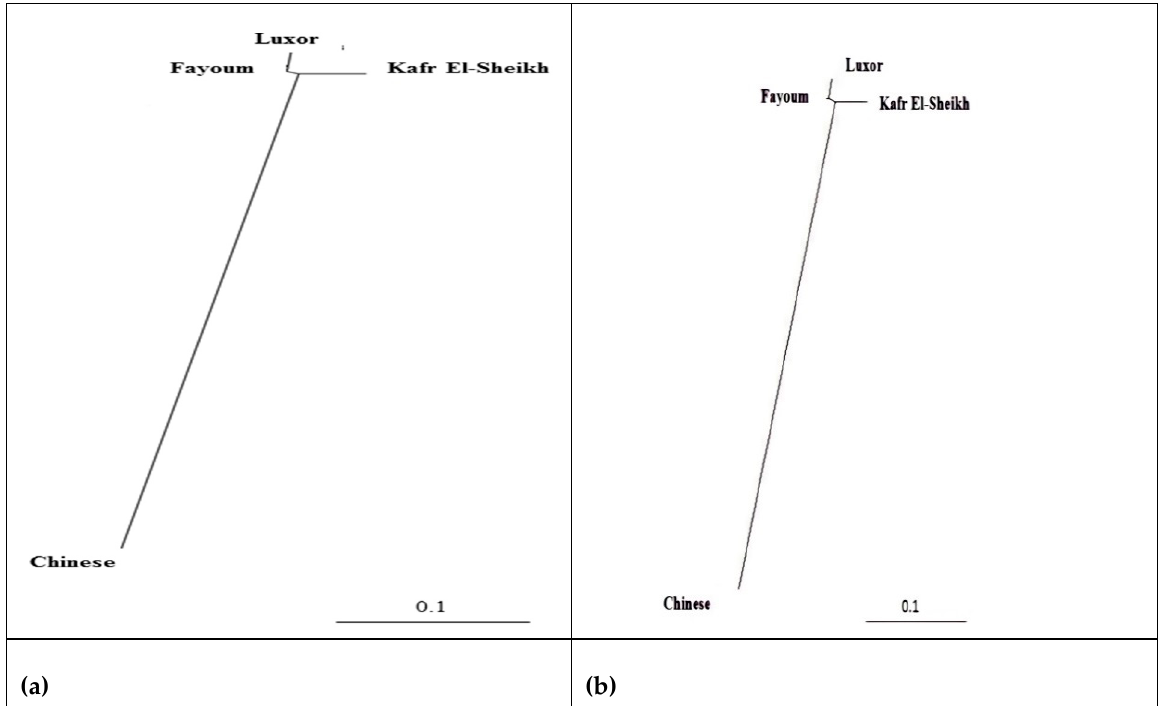
Figure 5. Neighbor-joining phylogenetic tree of the three Egyptian and Chinese goose populations by 11 microsatellite markers based on ( a ) Reynolds’ and ( b ) Nei’s genetic distances.